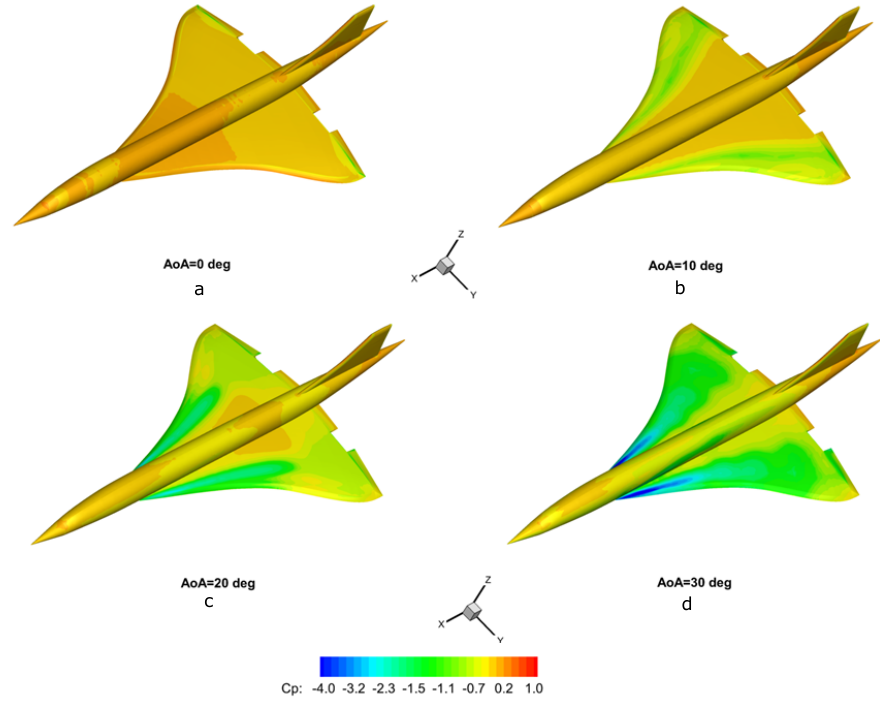
Figure 6. Pressure distribution on the aircraft leeside at different AoAs ( a ) AoA = 0 ◦ ; ( b ) AoA = 10 ◦ ; ( c ) AoA = 20 ◦ ; ( d ) AoA = 30 ◦